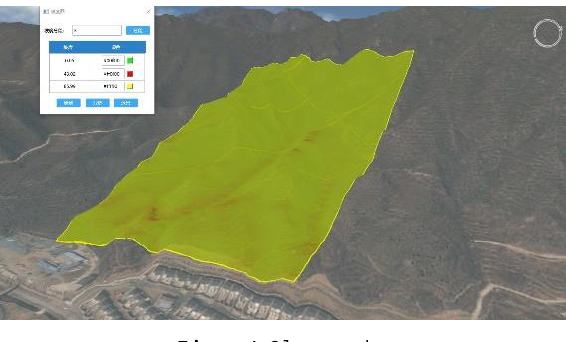
Figure 4 . Slope maphe.